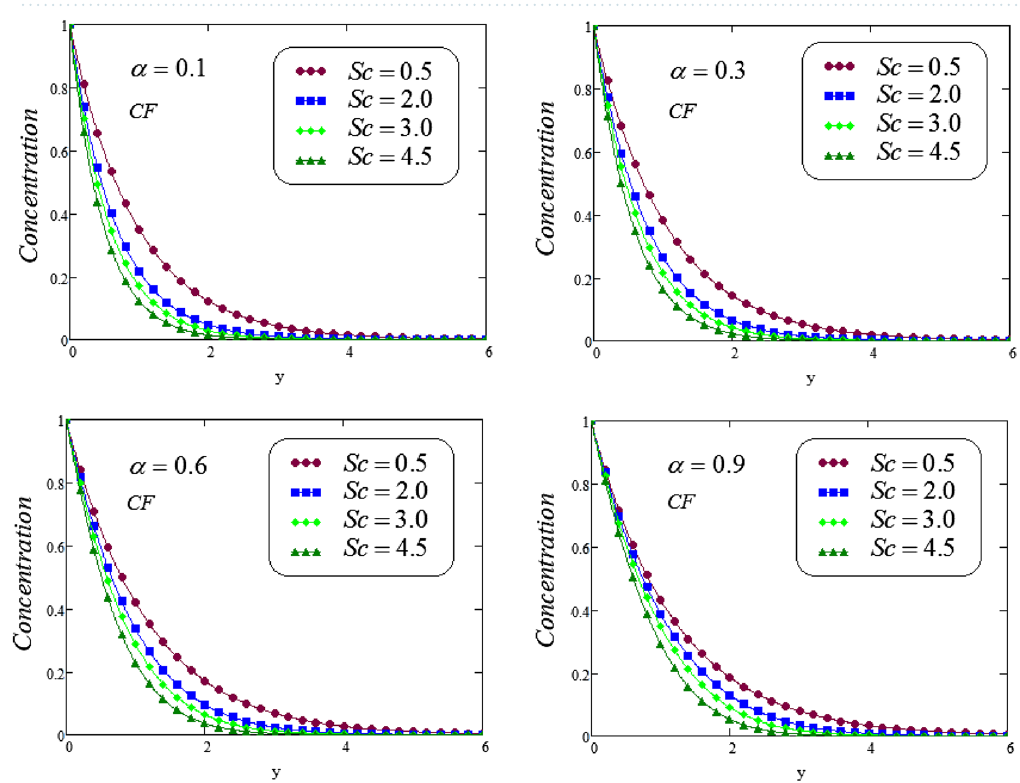
Figure 4. Representation of concentration profile via CF for distinct values of Sc at distinct values of the fractional parameter α